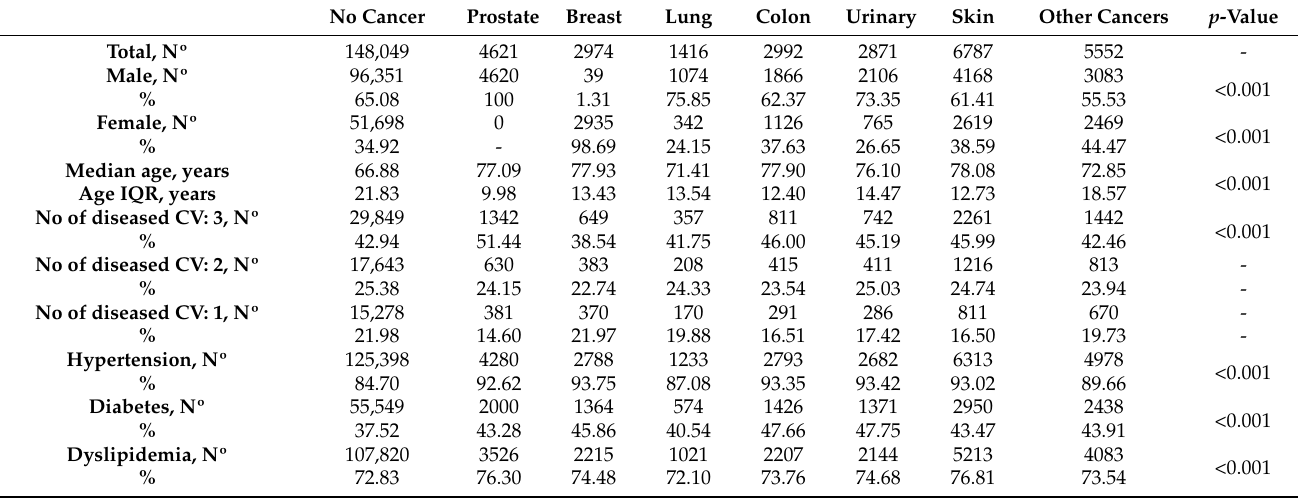
Table 1. Baseline